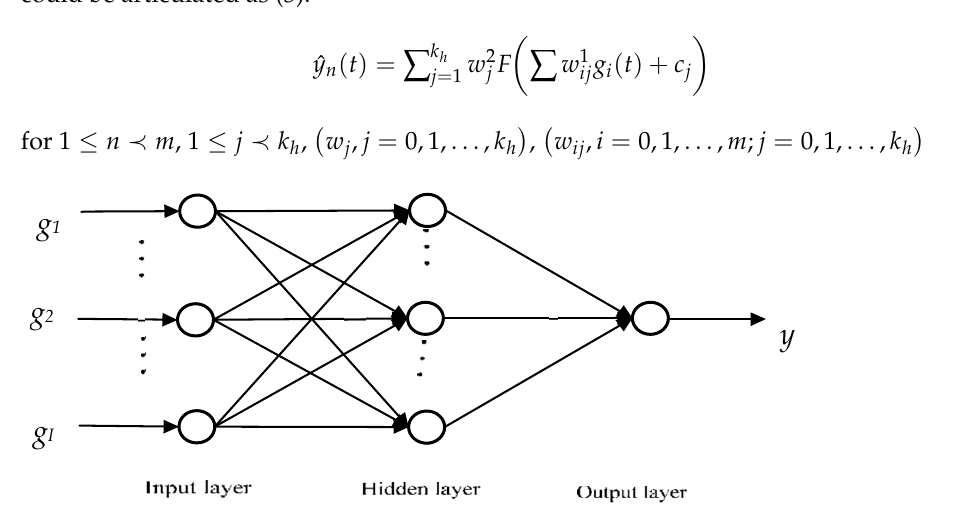
Figure 2. Scheme of a three-layered ANN multi-layer perceptron.